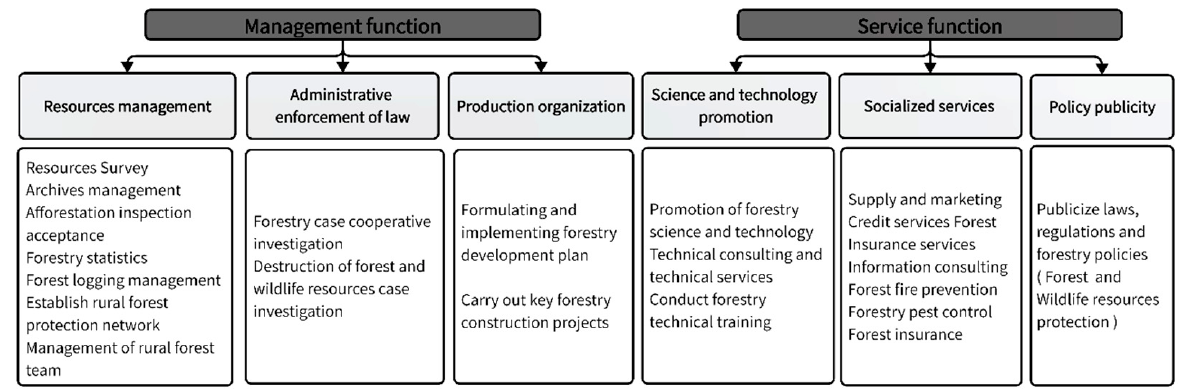
Figure 1. Main functions of township forestry workstations.